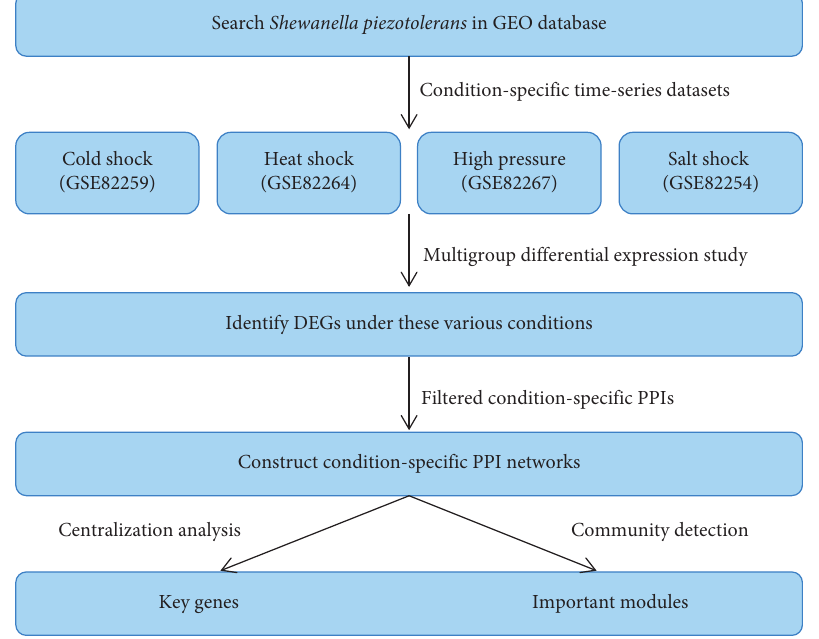
Figure 1: Overall view of the study. Step 1: four time-series expression datasets for S. piezotolerans WP3 were obtained from the GEO database; Step 2: the DEGs under these conditions were identified; Step 3: the identified DEGs were used to filter the global PPIs to construct condition-specific PPI networks; Step 4: condition-specific key genes and important modules were identified from these networks. GEO: gene expression omnibus; DEGs: differentially expressed genes; PPI: protein-protein